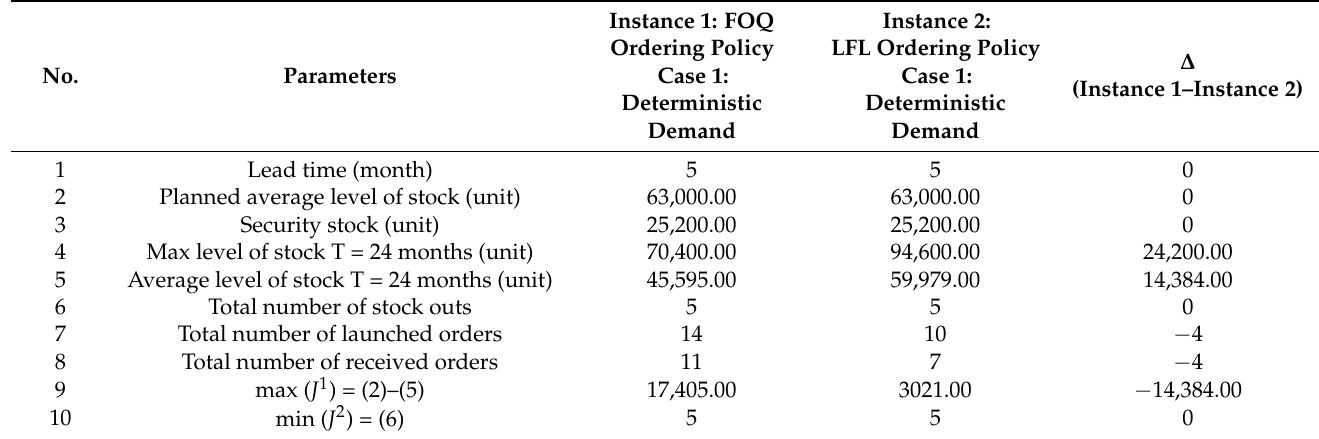
Table 4. Comparison of numerical results for Instance 1 and Instance 2 in Case 1.